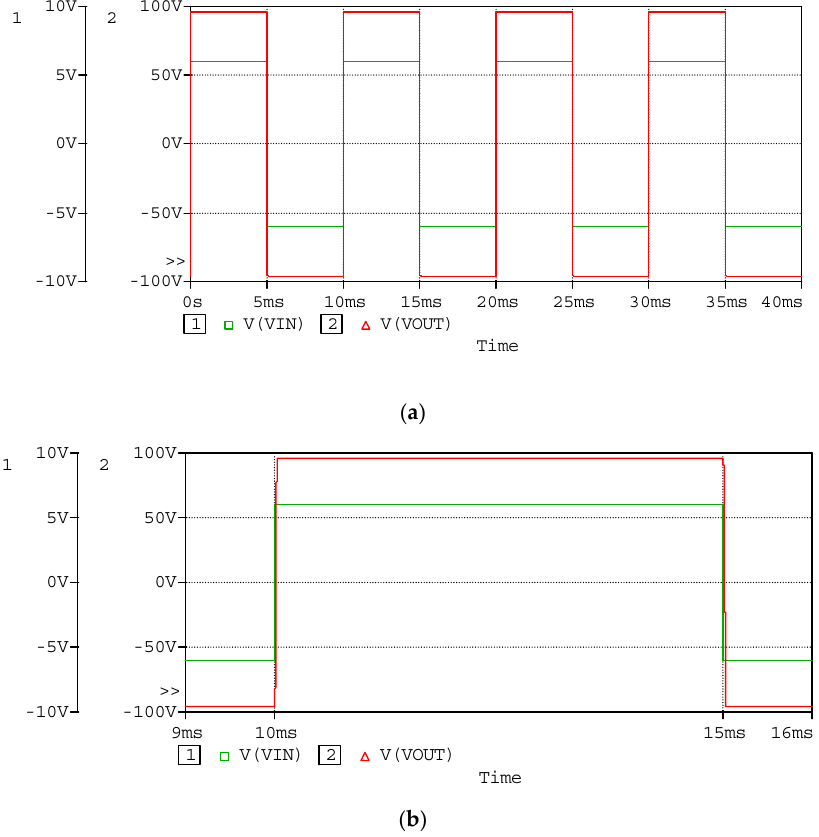
Figure 15. Simulated waveforms of input and output, as the input square wave has amplitude of 6 V and frequency of 100 Hz; ( a ) the overall perspective waveform; and ( b ) the rising edge and the falling edge of the waveforms.